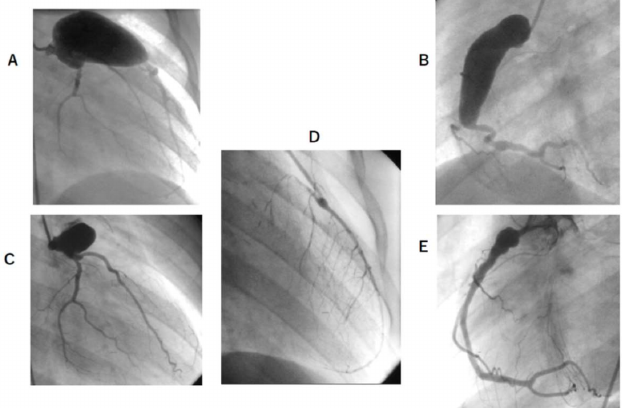
Figure 1. CAG of patient E before and after 92 months of CABG and RCA downsizing